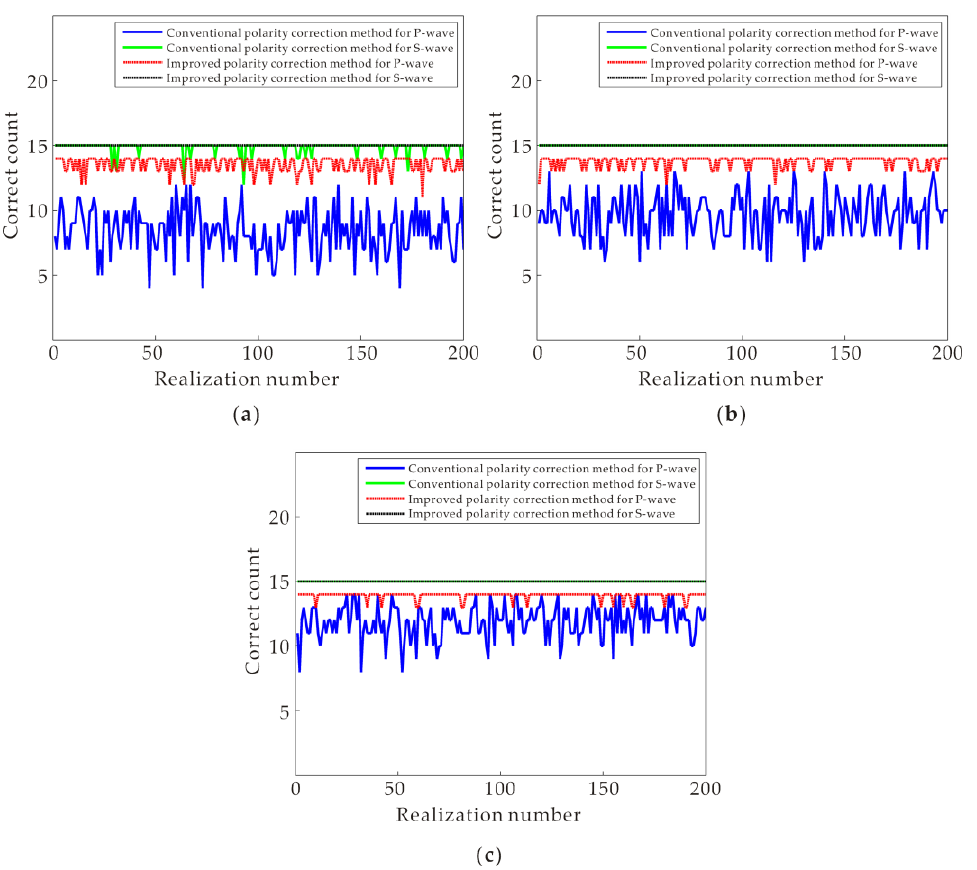
Figure 4. Comparison with correct counts of predicted polarity from the 200 realizations in the Monte Carlo test using the conventional and improved polarity correction methods, under independent random noise for different SNRs of ( a ) 0.15, ( b ) 0.25 and ( c ) 0.5. Blue and green solid lines represent correct counts of predicted polarity based on the conventional polarity correction method for P- and S-waves, respectively. Red and black dashed lines indicate correct counts of predicted polarity based on the improved polarity correction method for P- and S-waves, respectively.